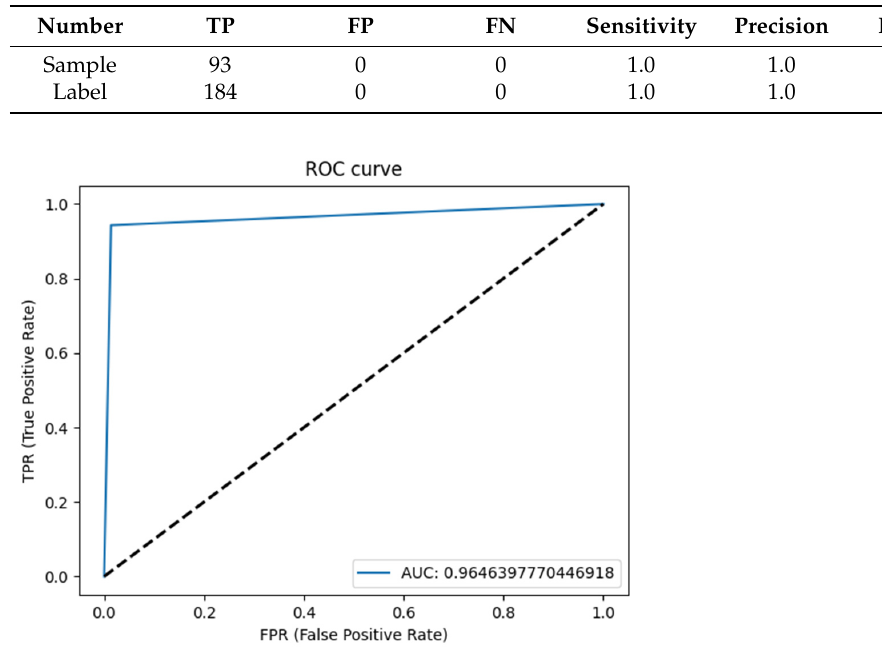
Figure 2. The automatic segmentation of the parotid gland utilizing the Artificial Intelligence model in axial CT slices. Table 1. Results showing the predictive performance utilizing the AI model (CranioCatch, Eskisehir- Turkey) in terms of segmenting the parotid gland with the testing data.